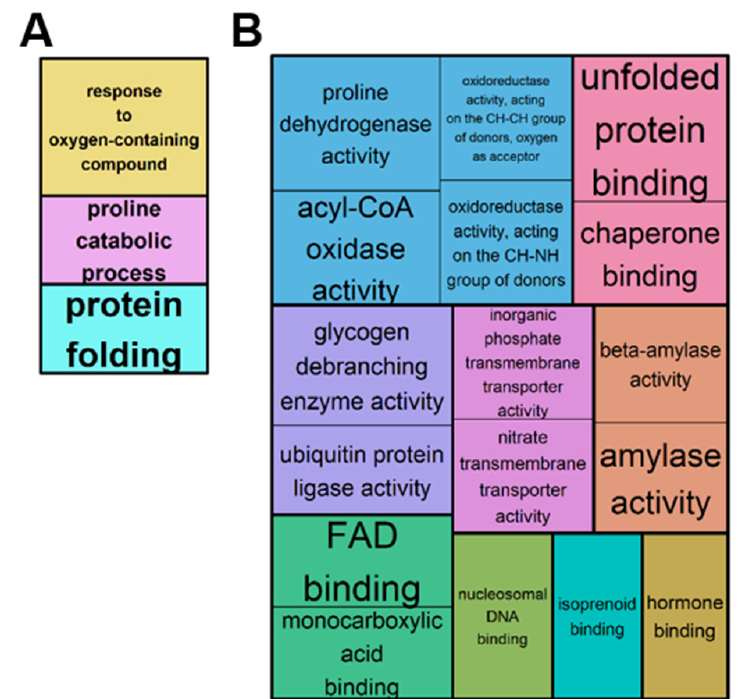
Figure 5. GO Enrichment analysis using g:Profiler then REVIGO for up and down DEGs overlapping between 5 d (mild), 11 d (severe), and 20 d (severe and extended) of WD compared to control plants. Significantly enriched GO terms in “biological process” ( A ) and “molecular function” ( B ) are represented in rectangles combined into superclusters with the most closely related terms, and sizes have been set to reflect the adjusted p -value ( p < 0.05).